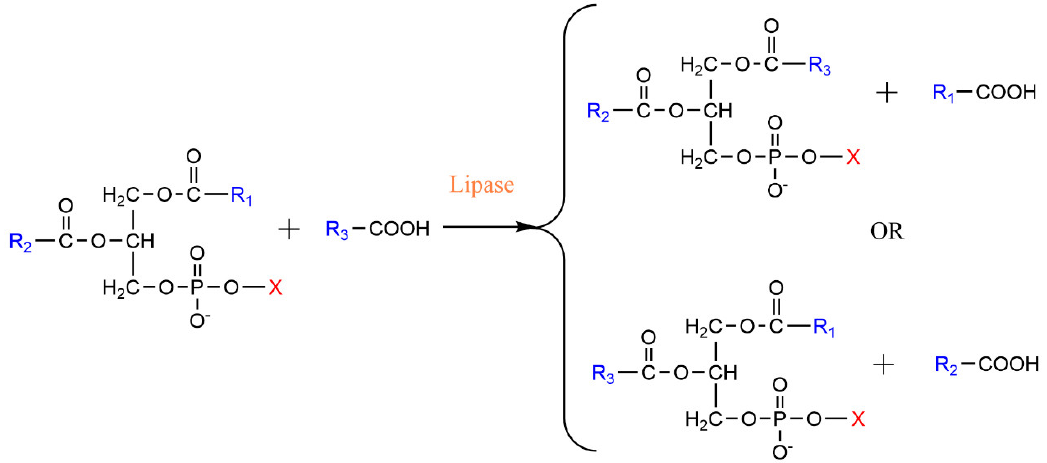
Figure 3. Lipase−mediated acidolysis reaction. Acidolysis occurs between an ester and an acid, re- Figure 3. Lipase − mediated acidolysis reaction. Acidolysis occurs between an ester and an acid, sulting in an exchange of acyl groups. resulting in an exchange of acyl groups. Table 1. Lipase−mediated of SPLs production by acidolysis. Table 1. Lipase − mediated of SPLs production by